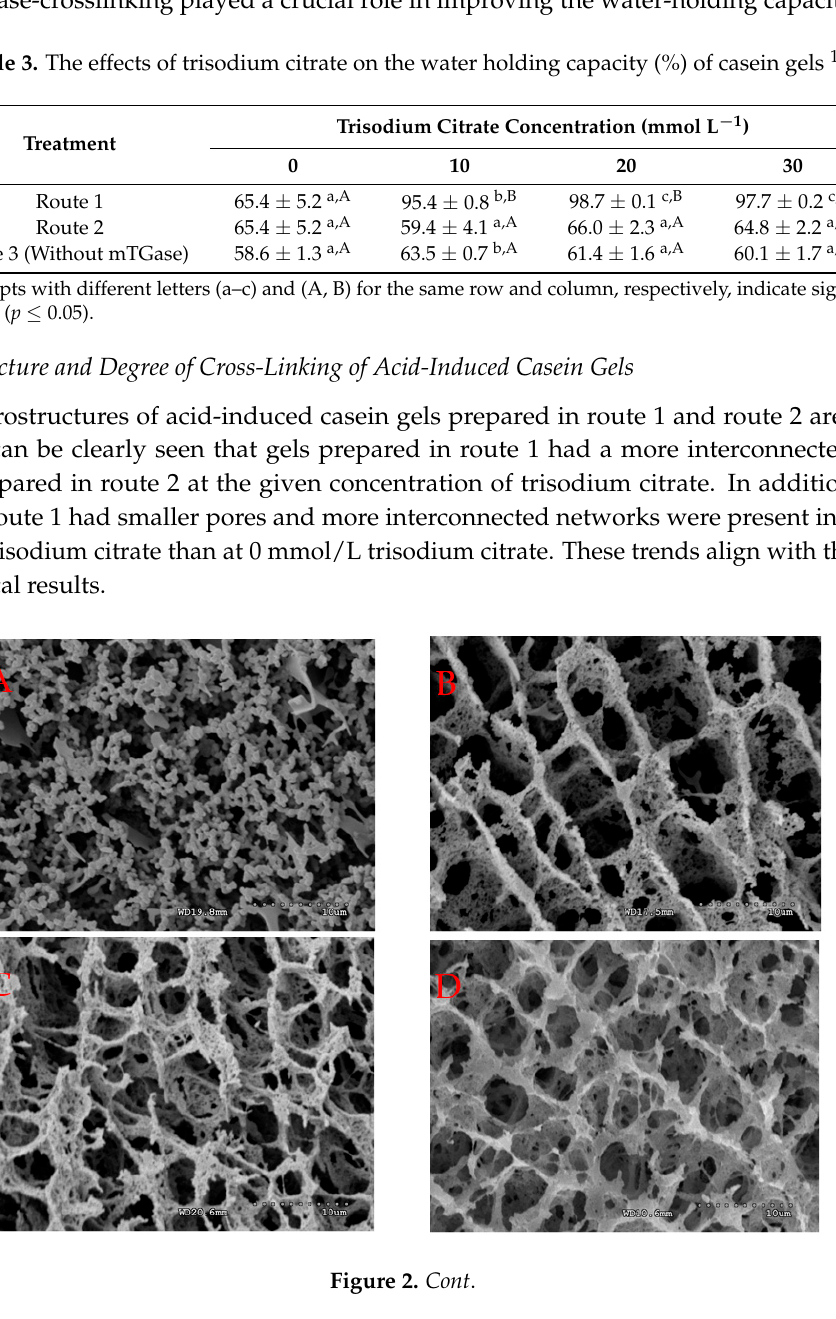
Table 3. The effects of trisodium citrate on the water holding capacity (%) of casein gels 1